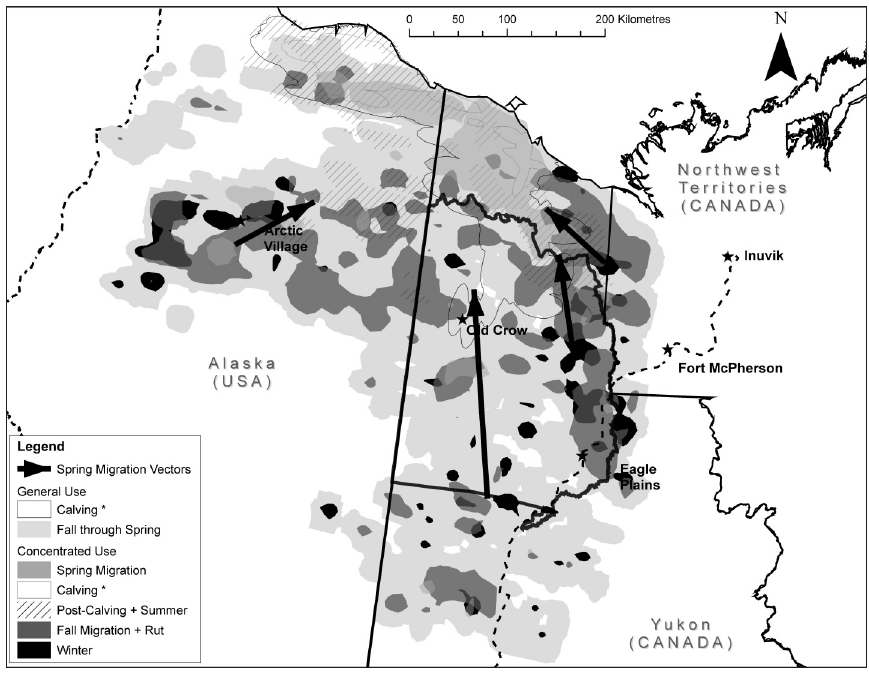
Fig. 2. General (99% isopleths) and concentrated use areas (60% isopleths) of the Porcupine caribou herd by season. Mean directional vectors (black arrows) show migration pathways between winter and spring migration seasons. * Calving areas shown as per Griffith et al.